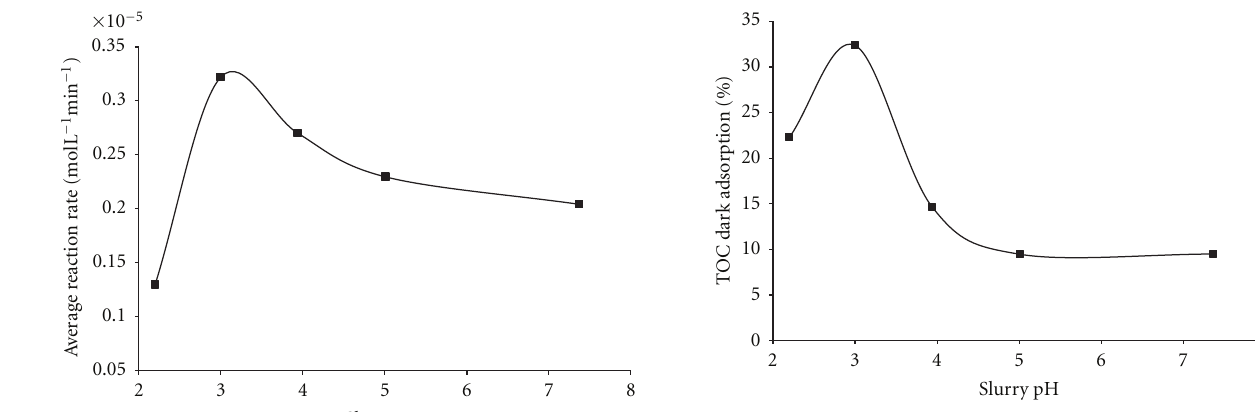
Figure 4: E ff ect of slurry initial pH on amount of TOC adsorbed in the